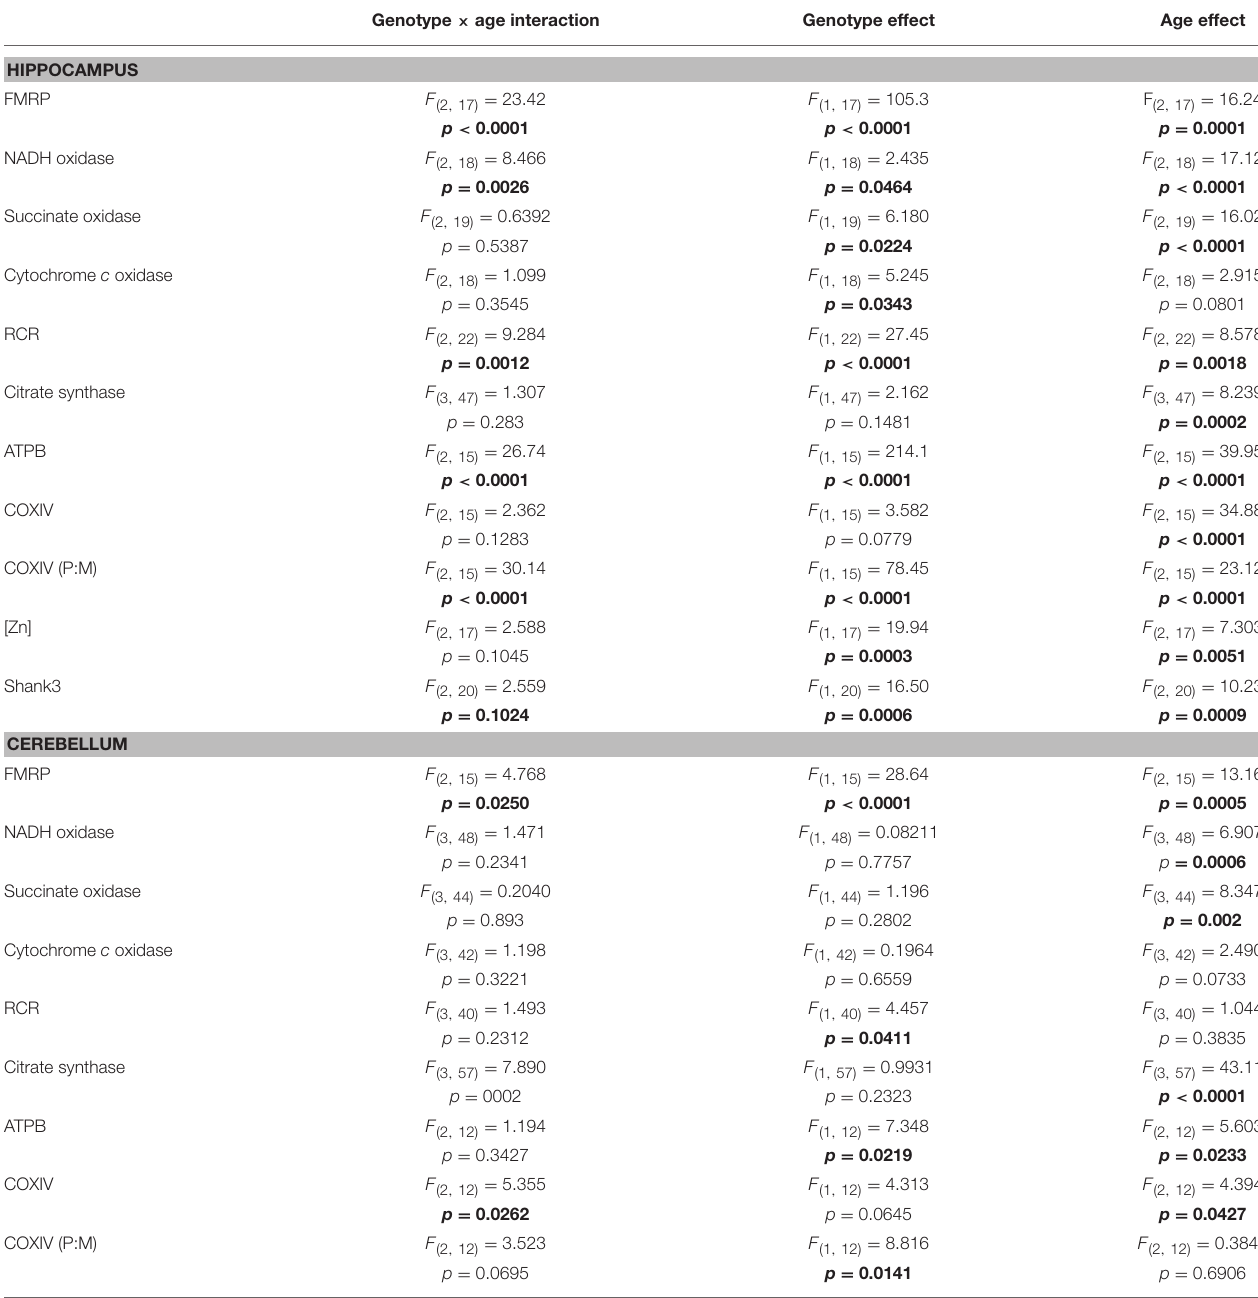
TABLE 3 | Effect of genotype, age, and genotype × age interaction on outcomes evaluated in hippocampus, cerebellum, and cortex of WT and KI